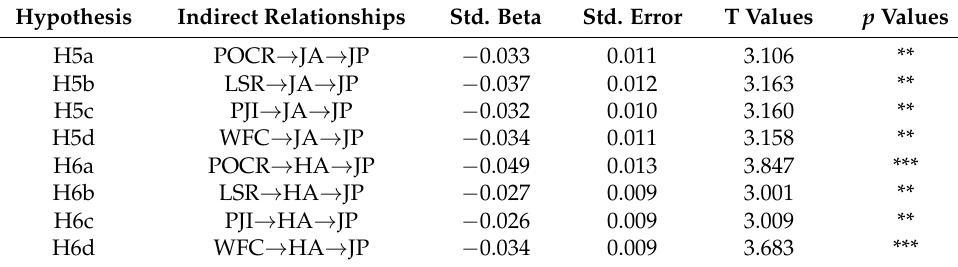
Table 9. Hypothesis results—indirect effects.